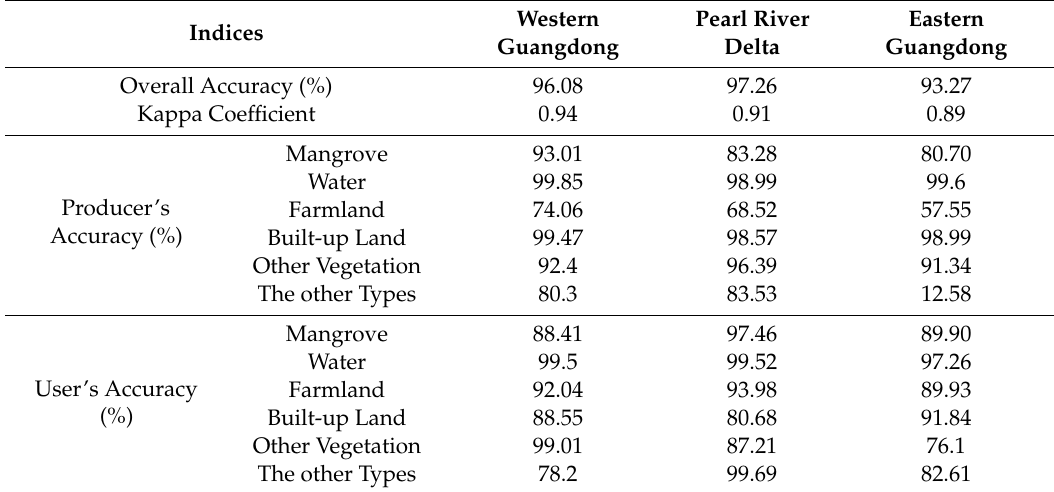
Table 3. Accuracy indices estimated from the classification image in 2015.